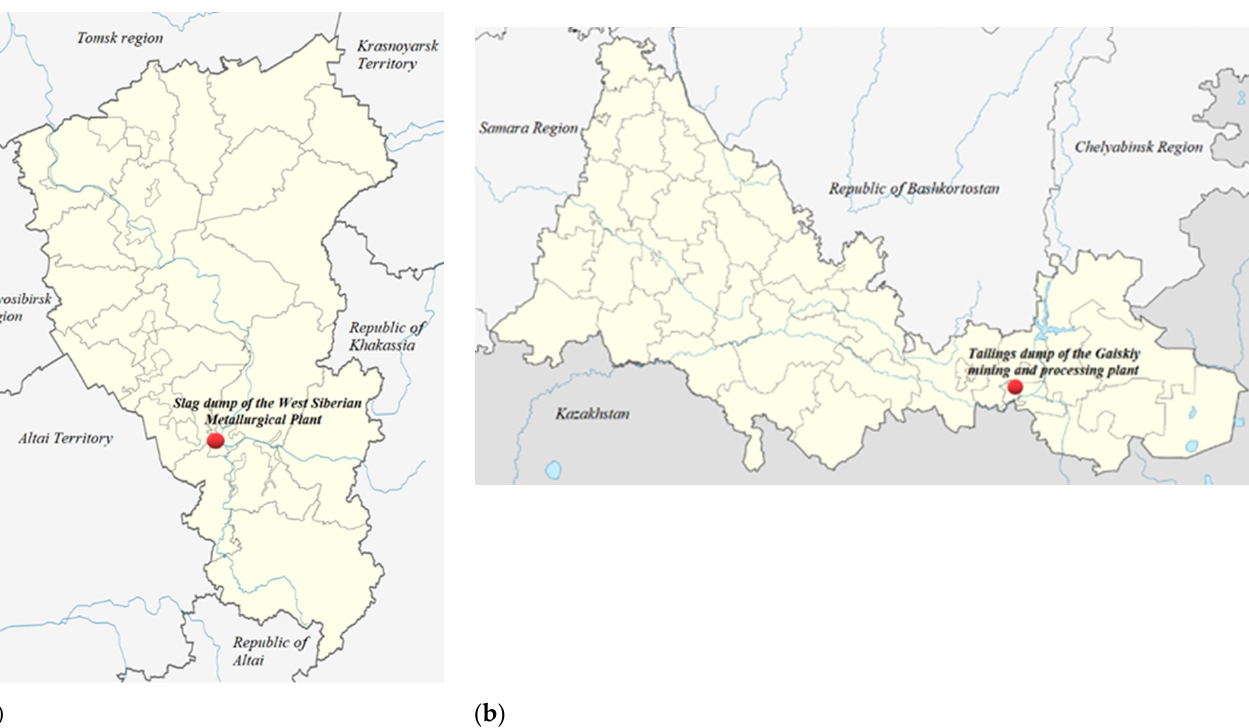
Figure 3. Location of the investigated anthropogenic materials: ( a ) metallurgical slags of the West Siberian metallurgical plant; ( b ) processing waste of the Gaysky mining and processing plant.